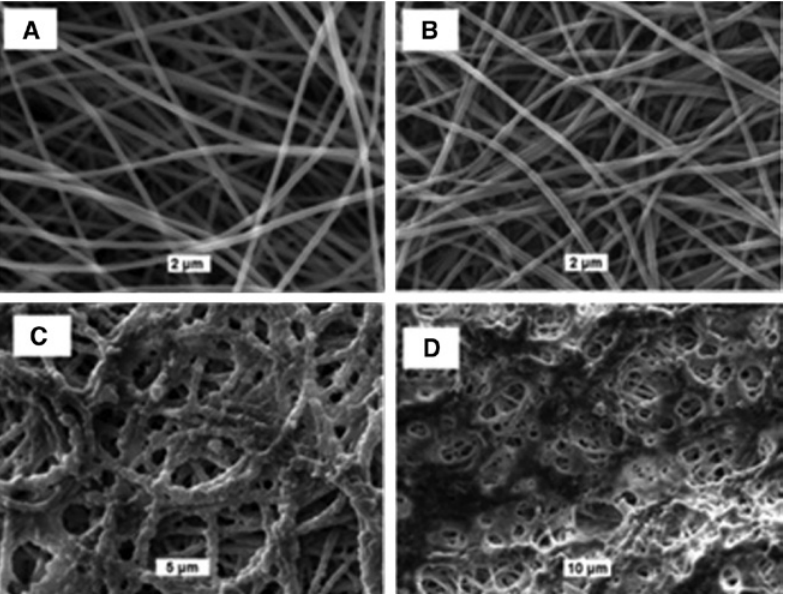
(scale bar: 10 (scale bar: 10 μ m). For 30